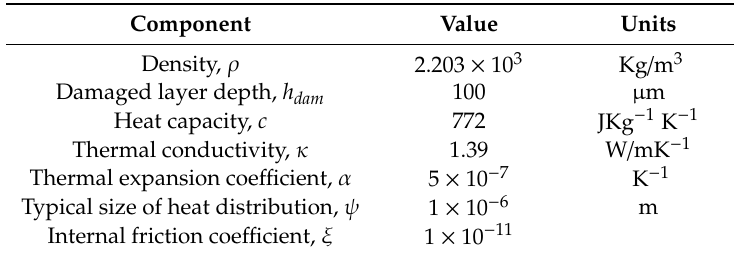
Table 1. Mechanical and thermal properties of fused